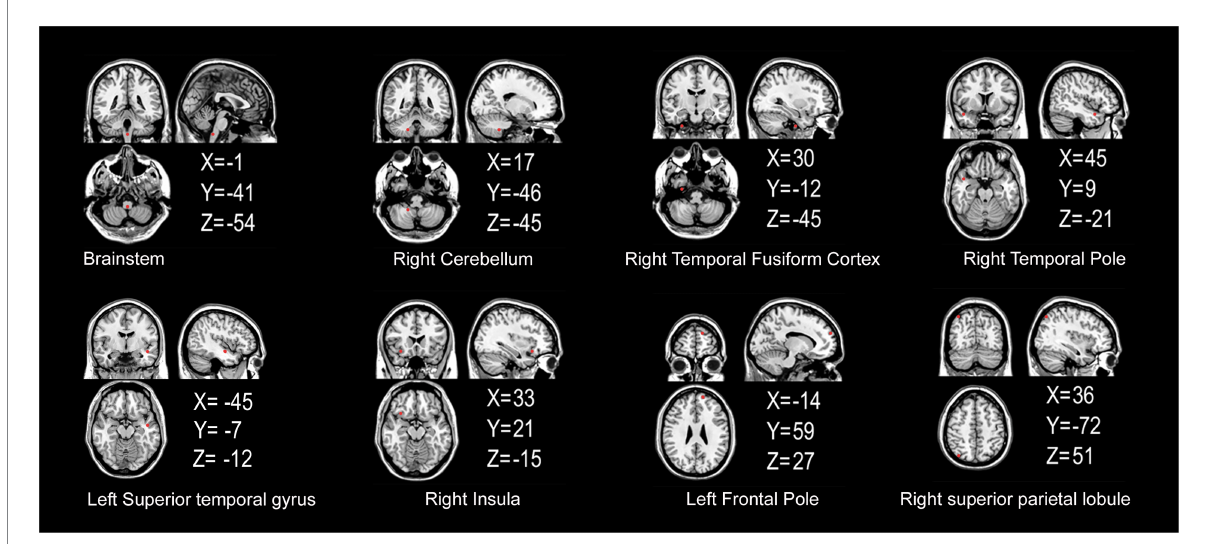
FIGURE 3 Gray matter areas with abnormal functional covariance connections. The areas marked in red represent the gray matter areas, where the FCS is statistically different between the PD and HC groups (two sample T -test, p < 0.00005). X, Y, and Z refer to the coordinate axes in the Montreal Neurological Institute space. PD: Parkinsons’s disease, HC: healthy control, FCS: functional covariance connection